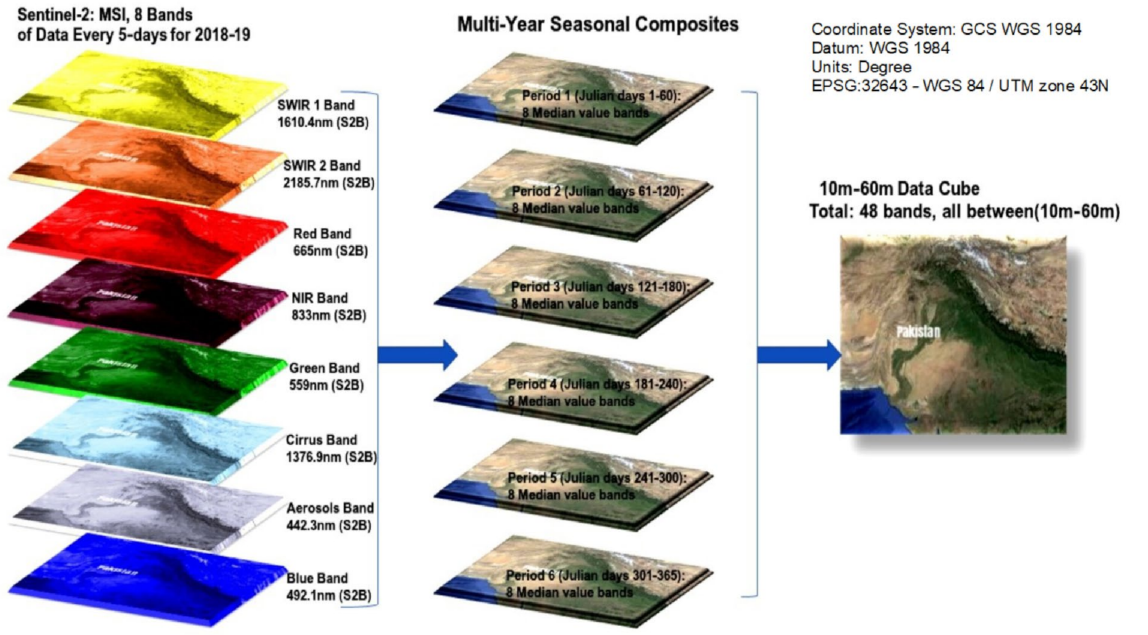
Figure 2. 10m to 60m Sentinel-2 MSI data were composed for six time-frames. Eight bands were formed for every time frame (e.g., time 1: Julian days 1–60), taking the median value of one pixel for each cycle (SWIR 1, SWIR 2, Red, NIR, Black, Cirrus, Aerosol, and